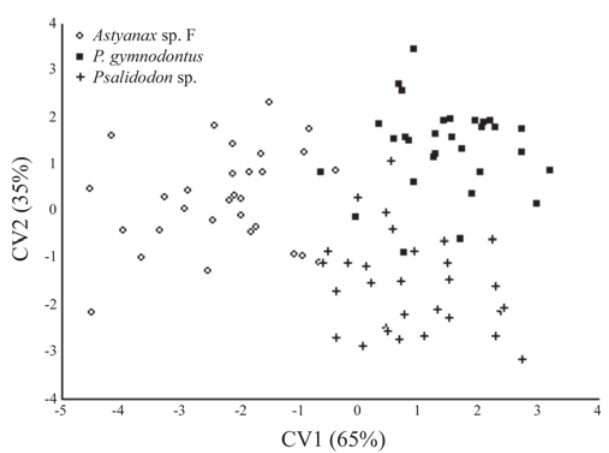
Fig. 3. Plots of scores obtained by canonical discriminant analysis of all measurements from the three